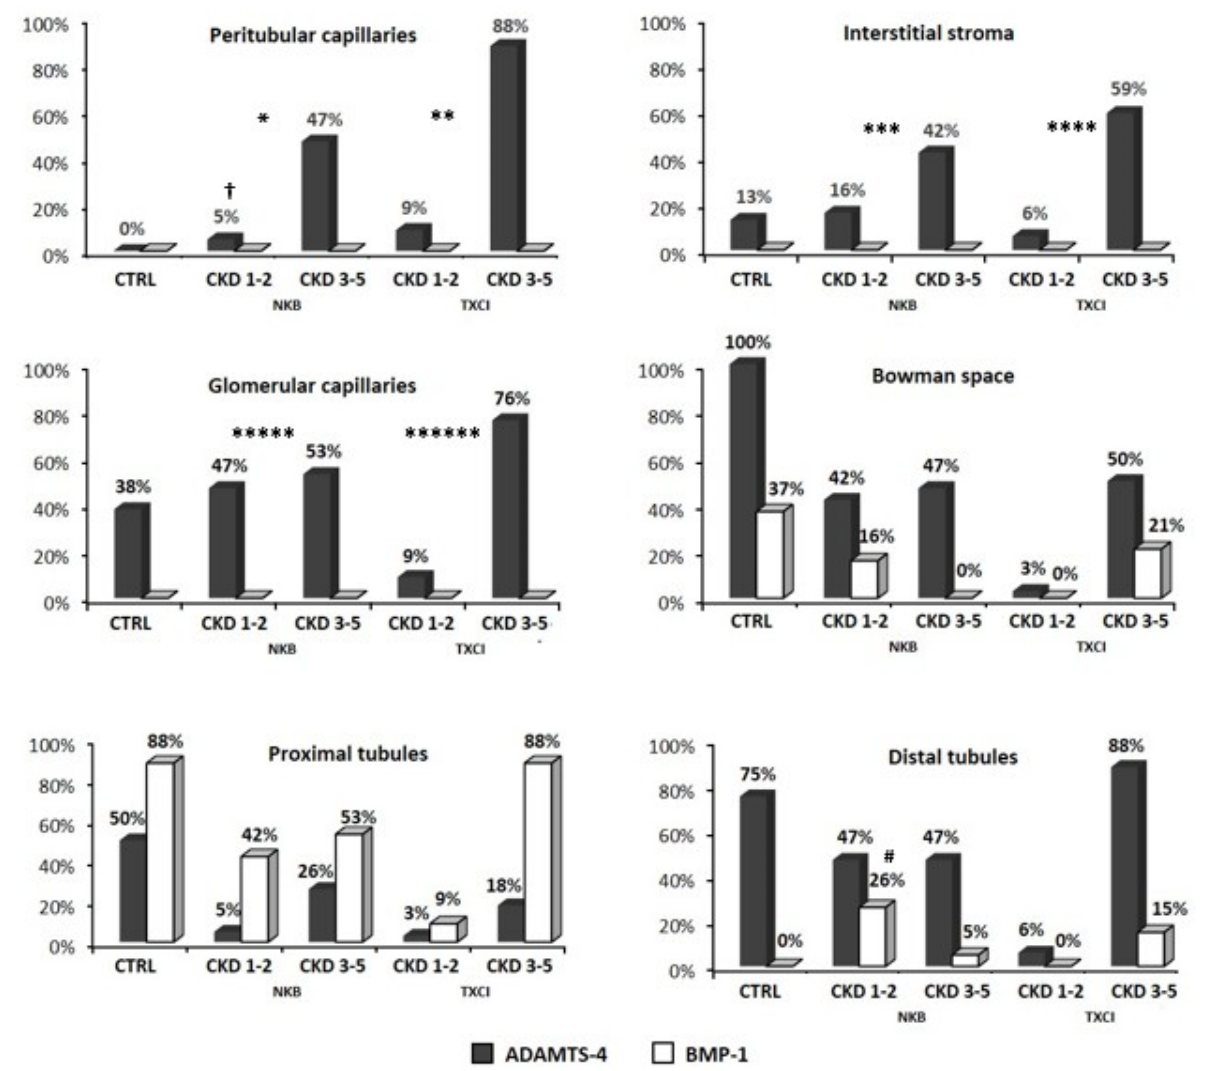
Figure 2. The distribution of ADAMTS-4 and BMP-1 molecules detected by